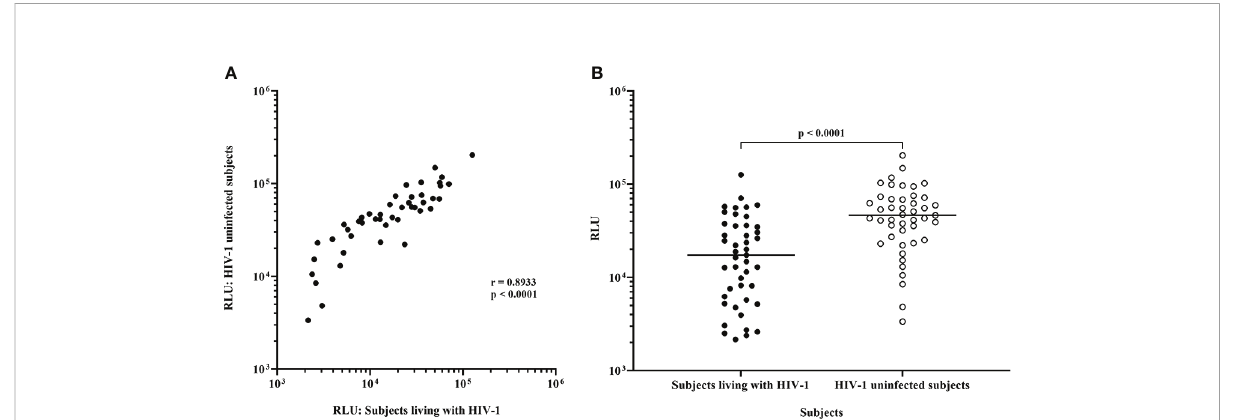
FIGURE 2 Replication of HIV-1 IMC-LucR in expanded CD4 T-cells from ART naive subjects living with HIV-1 or HIV-1 uninfected subjects. (A) Spearman correlation between replication of HIV-1 IMC-LucR in expanded CD4 T-cells from ART naive subjects living with HIV-1 or HIV-1 uninfected subjects. (B) Scatter plot of the same data with medians of the groups (bar) and p value generated with a Wilcoxon test. Each data point represents the median RLU of an IMC-LucR replicating in expanded CD4 T-cells from ART naive subjects living with HIV-1 or HIV-1 uninfected subjects.